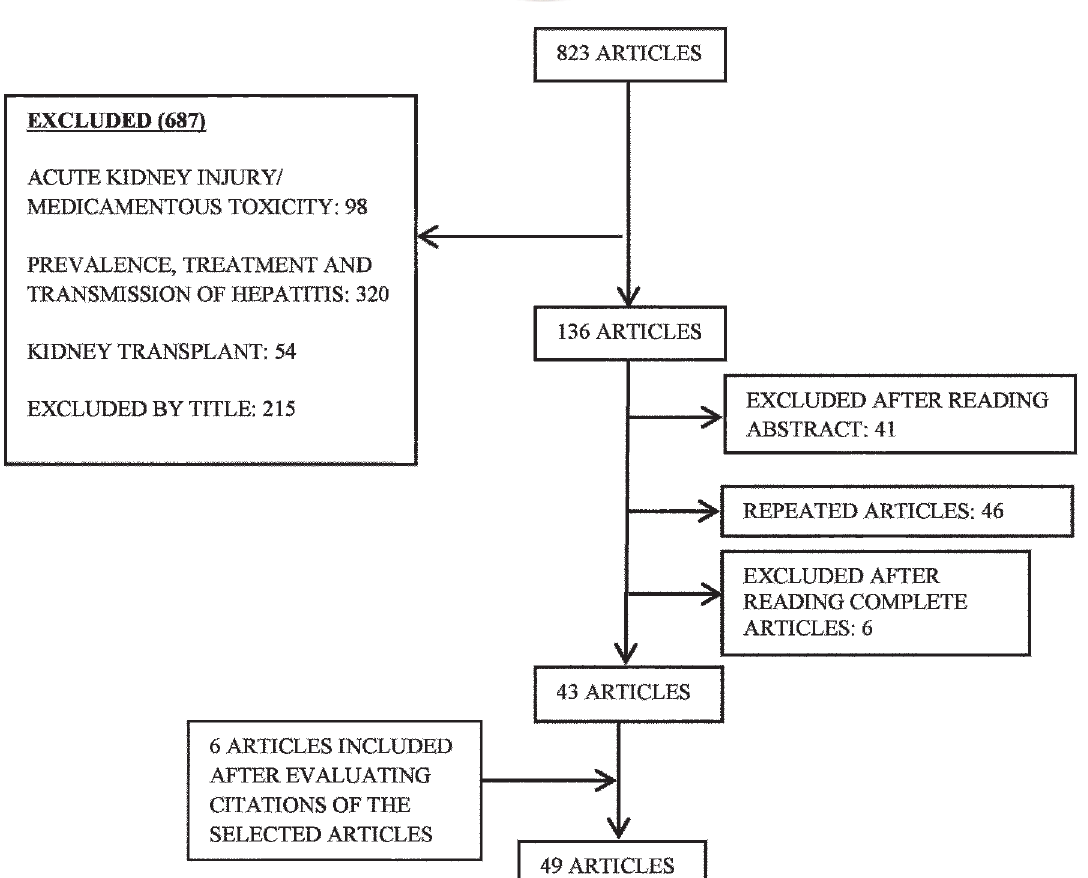
Figure 1 - Flow chart of article selection performed for the systematic